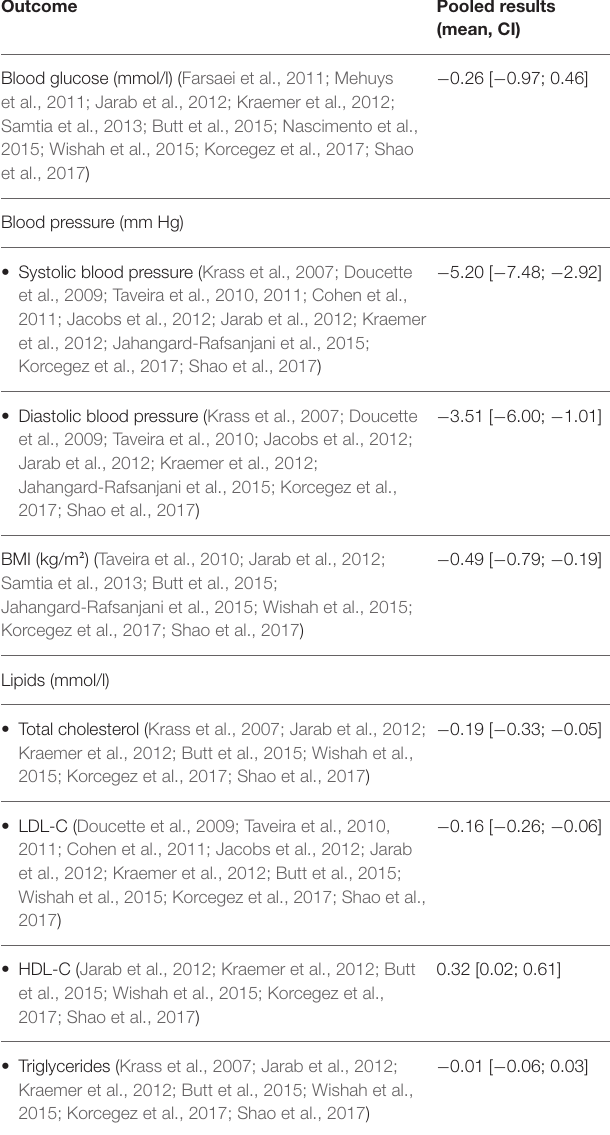
TABLE 4 | Pooled outcomes clinical parameters. Outcome Pooled results